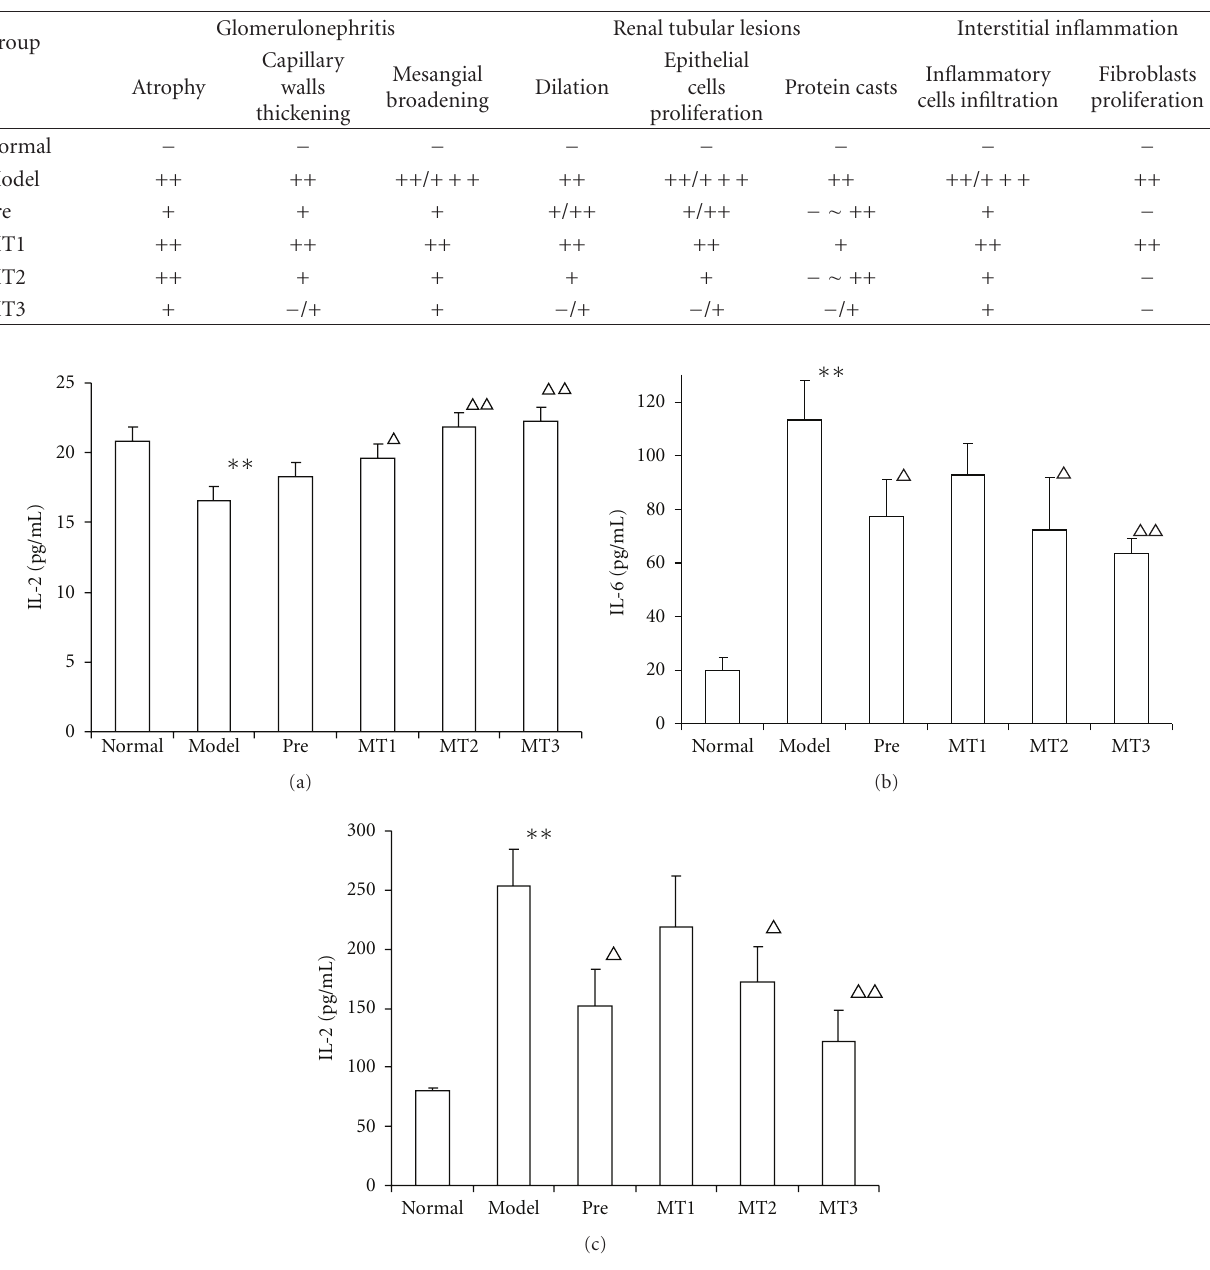
Table 1: Renal histopathological features of the mice in di ff erent groups ( n = 6–8). The degree of severity of histological lesions was evaluated as absent ( − ), mild (+), moderate (++), and severe (+ + +).